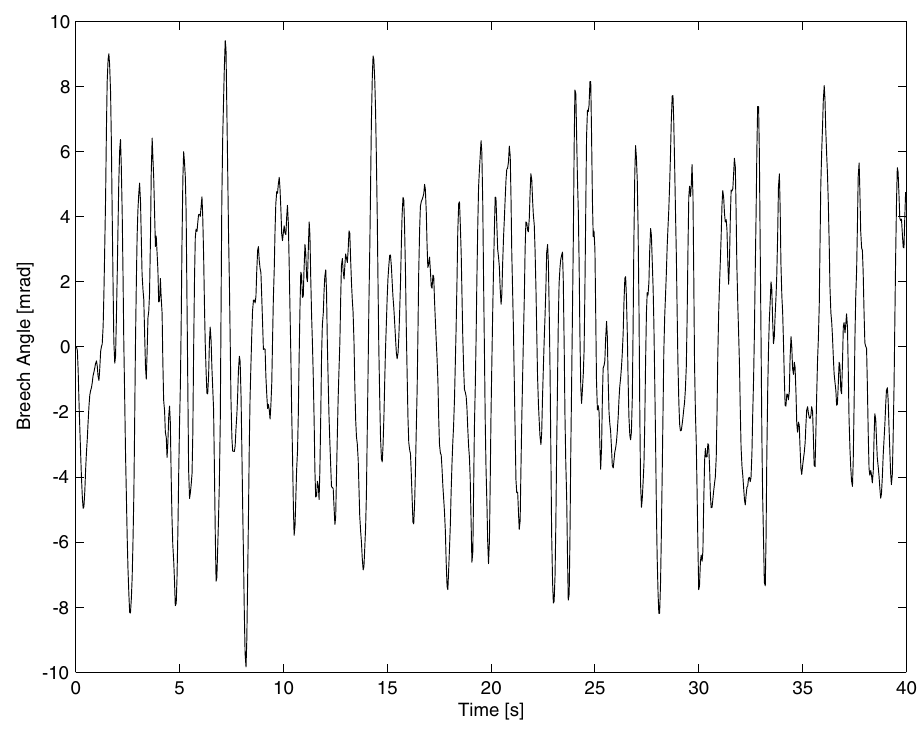
Fig. 6. Plot of the breech angle for the OOB without trunnion vertical acceleration